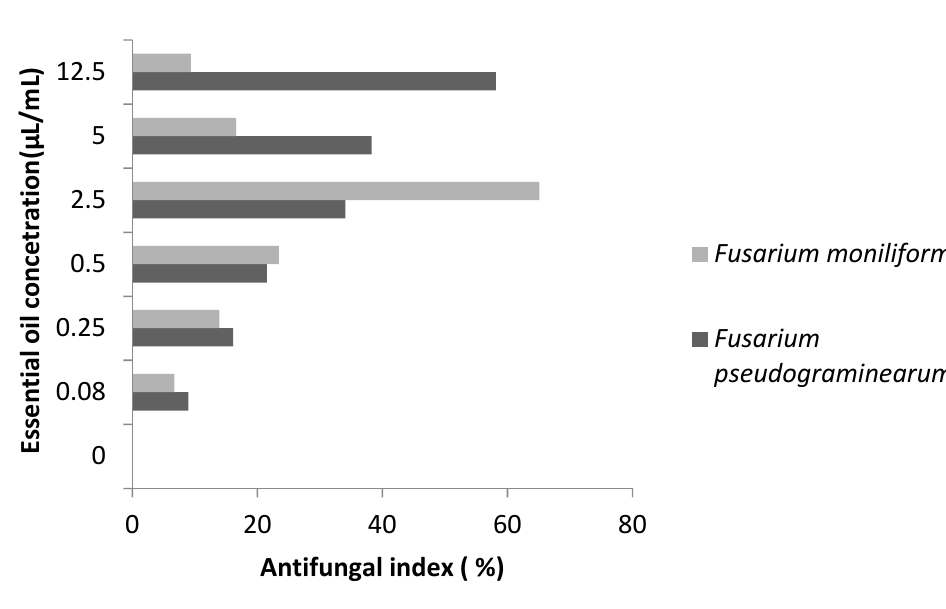
Figure 3. Antifungal index of M. vulgare essential oil.